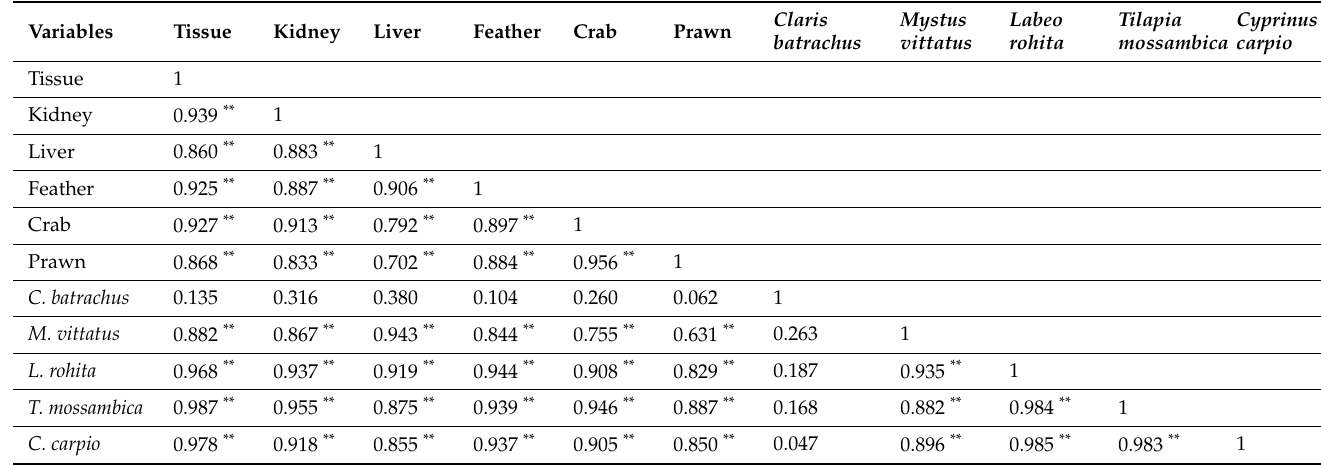
Table 5. Pearson correlation of different metals assessed between the various organs of the night heron ( Nycticorax nycticorax) and their prey species (bold letter with ** indicates the level of significance at p <